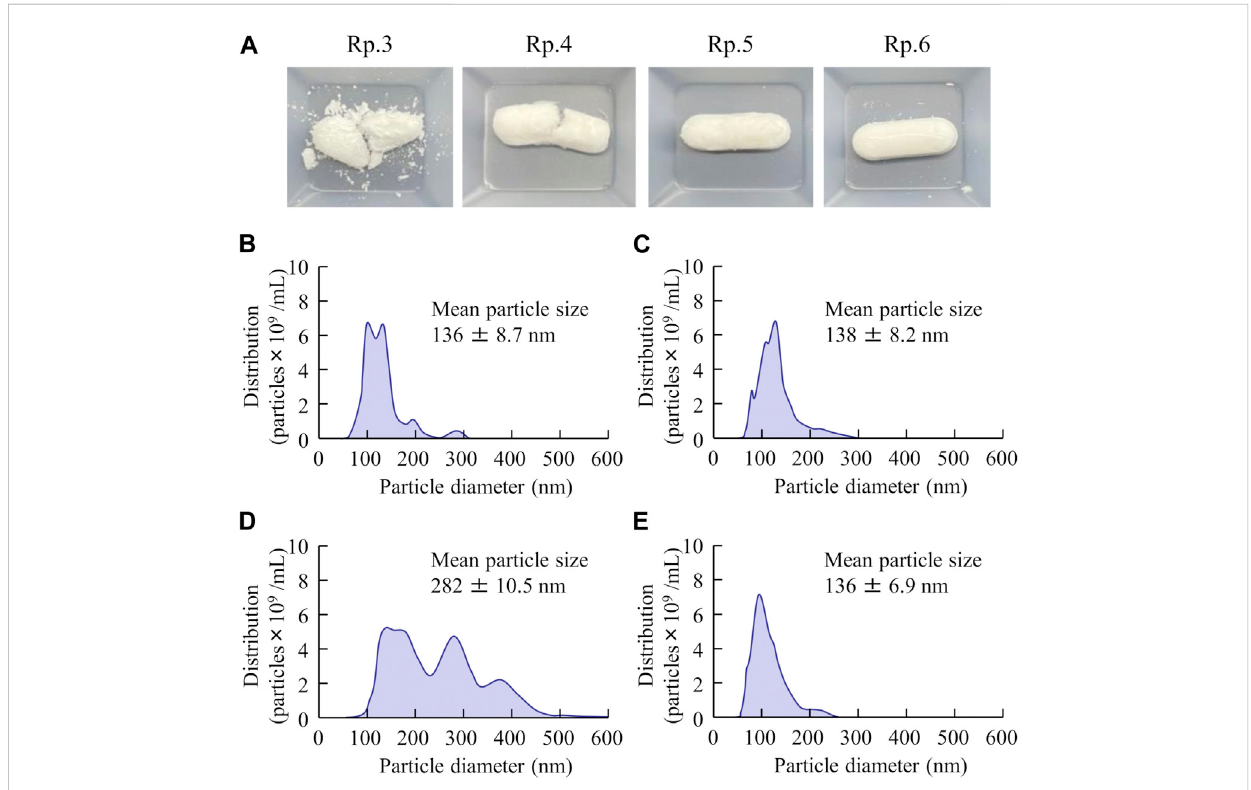
FIGURE 2 The image and particle size frequencies of FAM-NP tablets are listed in Table 1. Photograph of FAM tablets (A) , (Rp. 3 – 6 formulations). Particle size frequenciesofFAMinredispersedRp.3 (B) ,Rp.4 (C) ,Rp.5 (D) , andRp.6 (E) formulations.TheadditionofD-mannitol, PVP,andgum arabic formedatablet containing FAM nanoparticles, and the FAM particles in the redispersion of the FAM-NP tablet (Rp.6 formulations) were